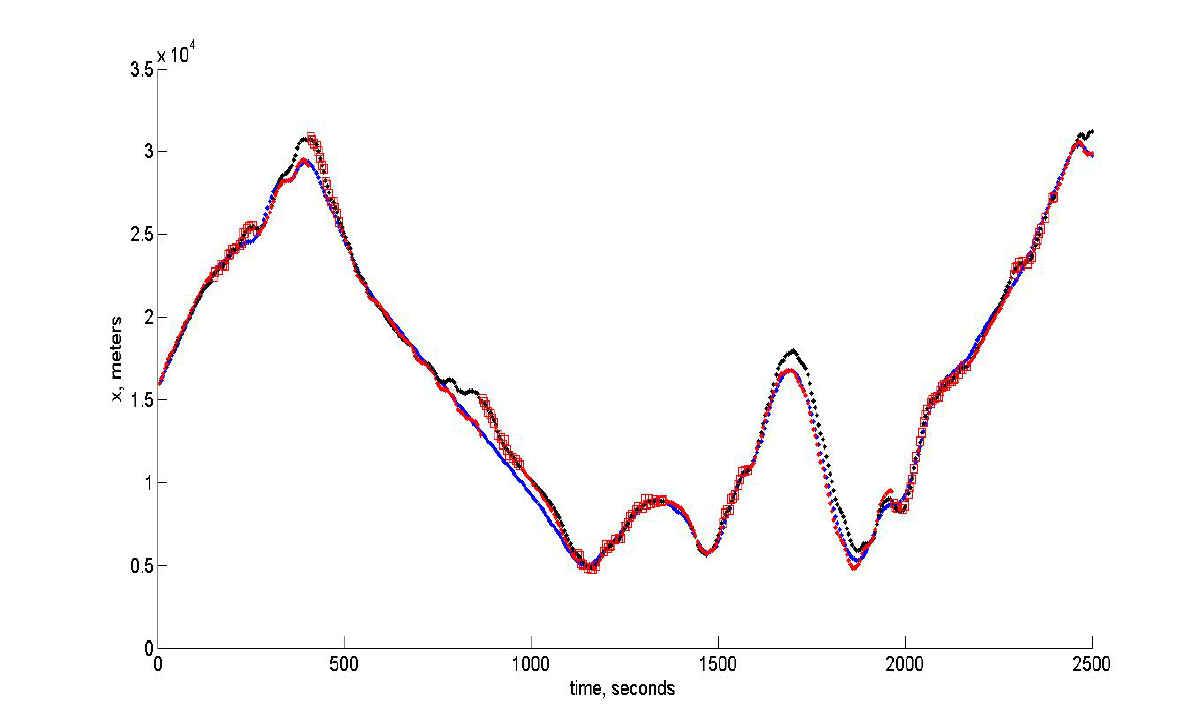
Figure 8. Tracking of the y